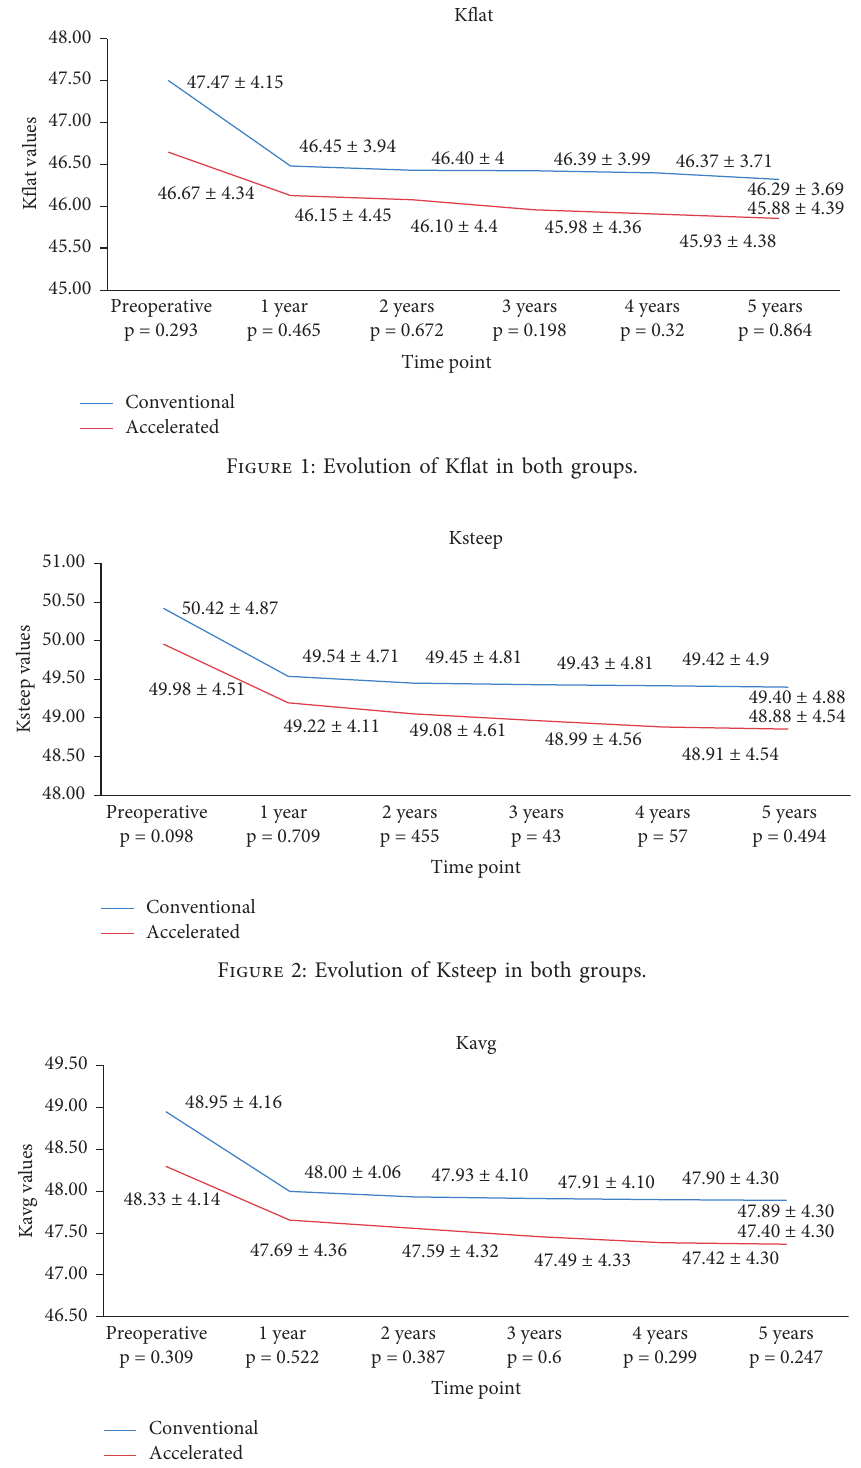
Figure 3: Evolution of Kavg in both groups.